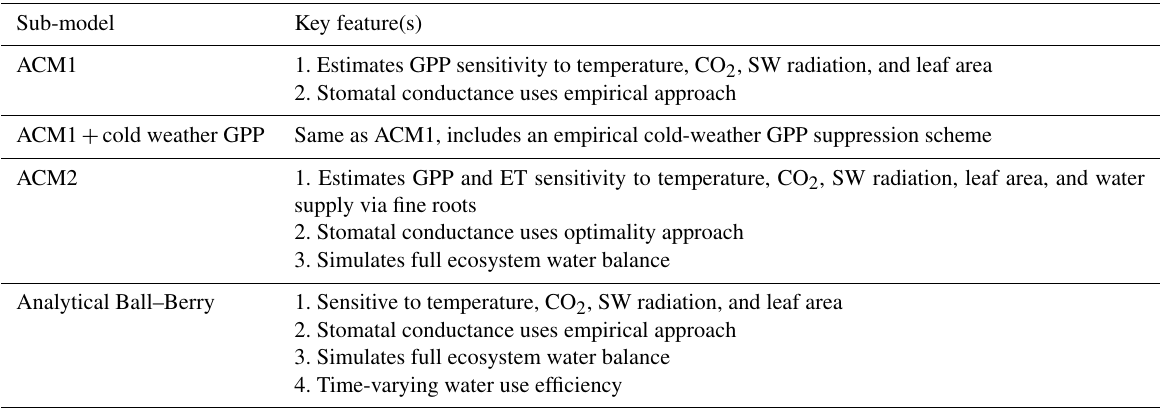
Table A1. Summary of the key features for each photosynthesis sub-model. Sub-model